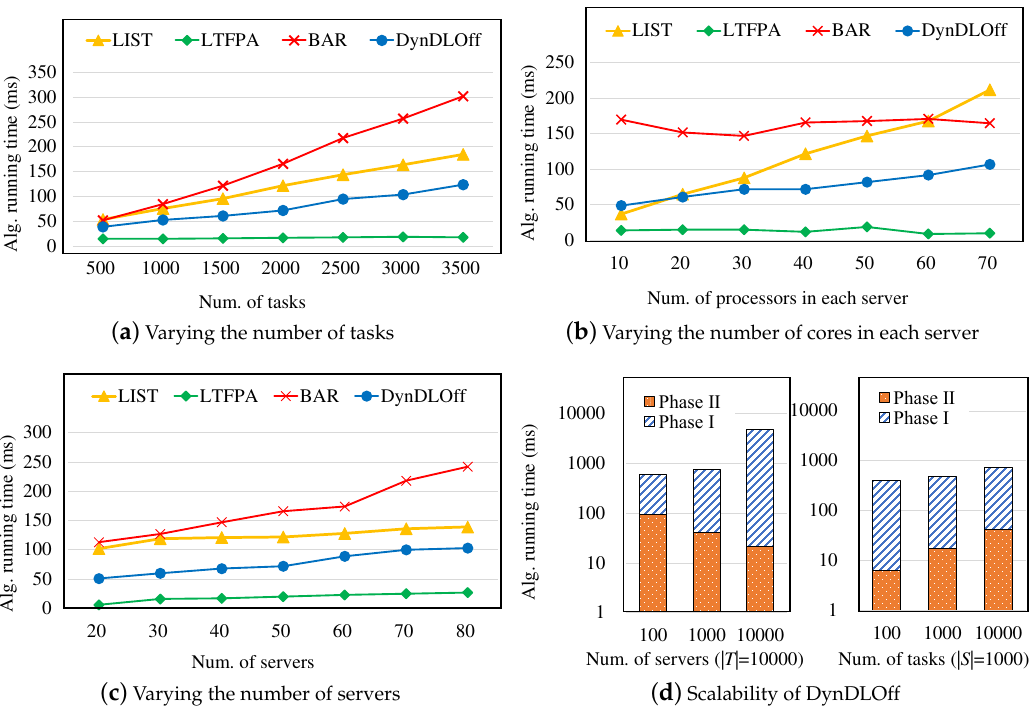
Figure 9. Algorithm running